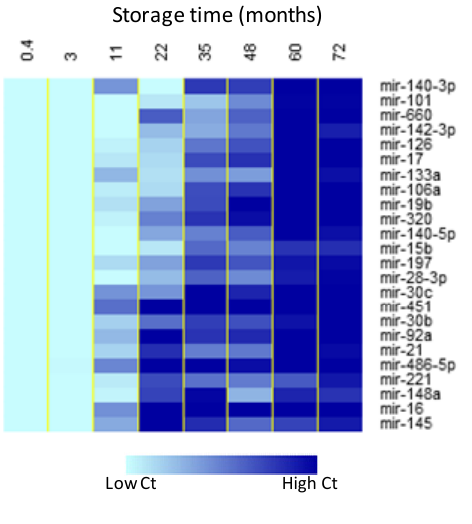
Figure 3. miRNA degradation according to storage time reported as ( A ) heat map of the time course analysis, and ( B ) dendogram using centred correlation and average linkage for miRNAs clustering. Analysis performed with BRB ArrayTools. Storage time (months)